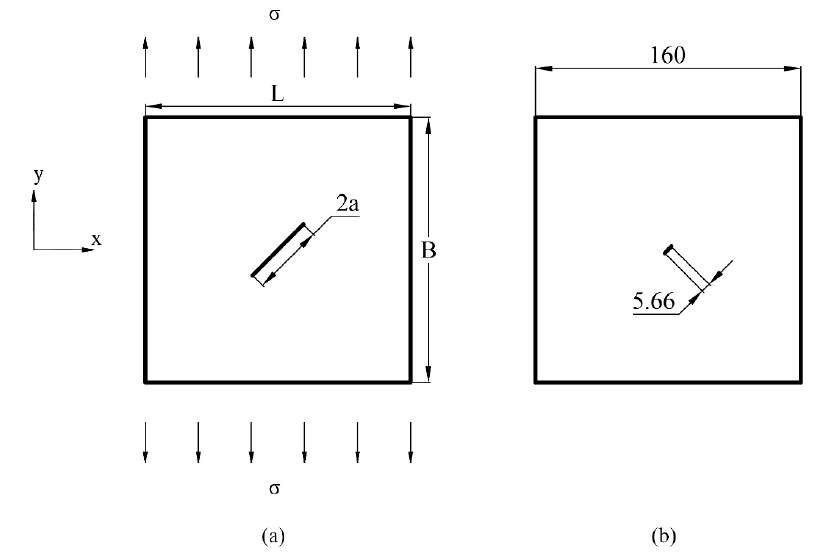
Figure 15. ( a ) Loading condition of the plate with an inclined crack in the center; ( b ) Size comparison between crack and plate in this example.